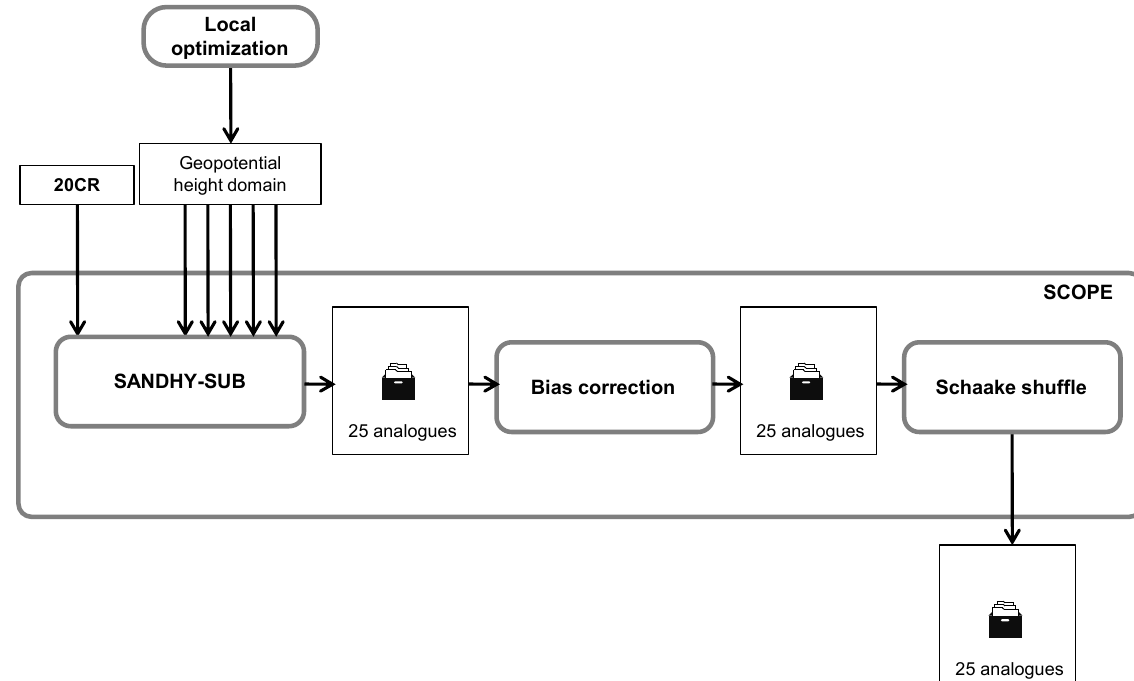
Figure B1. Synthetic diagram showing the sequence of steps for the SCOPE method and its use for (20CR-driven) SCOPE Climate recon- structions. See Sect. 2.2.2 for